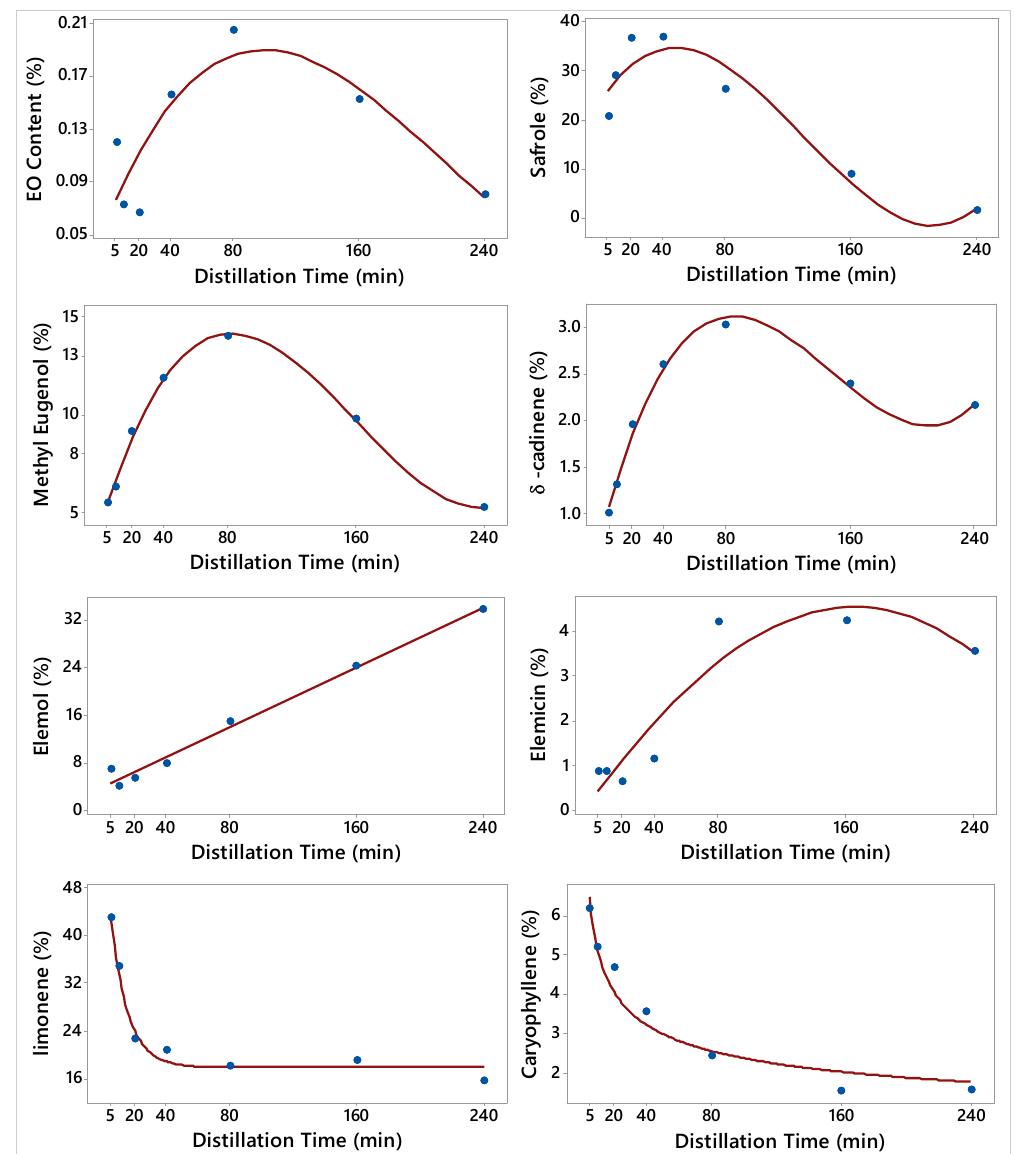
Figure 1. Plot of Distillation time vs. the essential oil (EO) content and the concentrations of 7 constituents along with the fitted Third order polynomial, Asymptotic, and Power regression models for Juniperus virginiana . The fitted models are: ˆ Y = 0.06 + 0.003 DT − 0.00002 DT 2 + 0.0000001 DT 3 (EO content), ˆ Y = 23.64 + 0.496 DT − 0.0064 DT 2 + 0.00002 DT 3 (Safrole), ˆ Y = 4.1 + 0.28 DT − 0.002 DT 2 + 0.000005 DT 3 (Methyl Eugenol), ˆ Y = 0.76 + 0.06 DT − 0.0005 DT 2 + 0.000001 DT 3 ( δ -cadinene), ˆ Y = 3.99 + 0.125 DT (Elemol), ˆ Y = 0.2 + 0.05 DT − 0.00012 DT 2 + 0.0000001 DT 3 (Elemicin), ˆ Y = 17.9 + 40.8 ( Exp ( − 0.093 DT )) (limonene), and ˆ Y = 11.14 DT − 0.336 (Caryophyllene). The major chemical families of the J. virginiana EO constituents were monoterpene hydrocarbons (MH), phenylpropene (PH), sesquiterpenes (bicyclic, monocyclic oxygenated ST), and polycyclic aromatic hydrocarbon (PCH) (Table 3). During the first 5 min of the distillation, about 43% of the monoterpenes (e.g. limonene) were eluted. The quantity of the monoterpenes elution gradually decreased as the distillation time increased, and it reached the bottom (15.6%) at 240 min. Limonene concentration at the 0–5 min timeframe was 177% higher than that eluted at 160–240 min timeframe fraction.